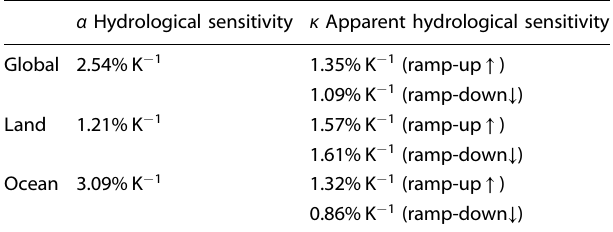
Fig. 2 Precipitation and temperature relationship changes during CO 2 ramp-up, ramp-down, and stabilization periods. a The percentage change of global mean precipitation and the global mean surface temperature anomaly during CO 2 ramp-up, ramp-down, and stabilization periods. b – d Same as a , except they are over land, ocean, and land minus ocean, respectively. Each dot represents the annual mean anomaly obtained by subtracting the PD simulation climatology from the ensemble mean. The percentage anomaly is de fi ned as the difference between the ensemble mean and PD simulation divided by PD simulation. Table 1. Summary of hydrological sensitivity and apparent hydrological sensitivity in a